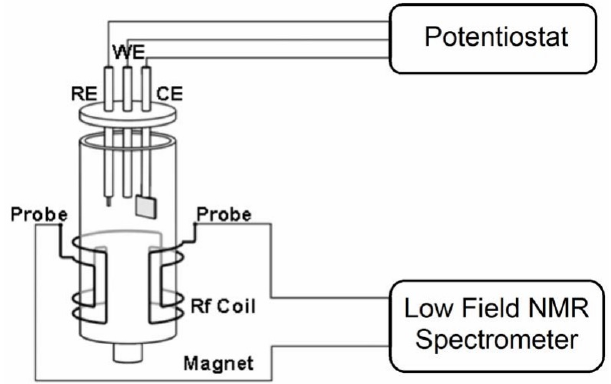
Figure 2. Schematic diagram of the EC-NMR cell used by Barbosa et al. WE, CE and RE refer to the working, counter and reference electrodes, respectively. Reproduced with permission from [10]. Copyright (2010), The Electrochemical